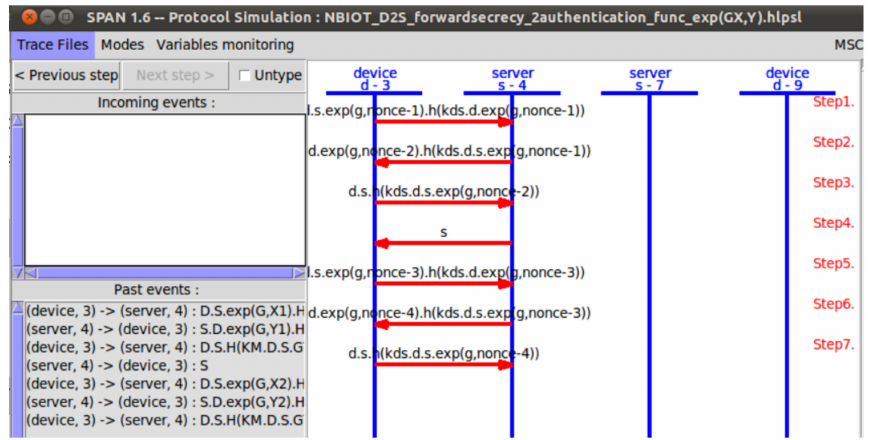
Figure 9. The message sequences of two successive D2S authentications.